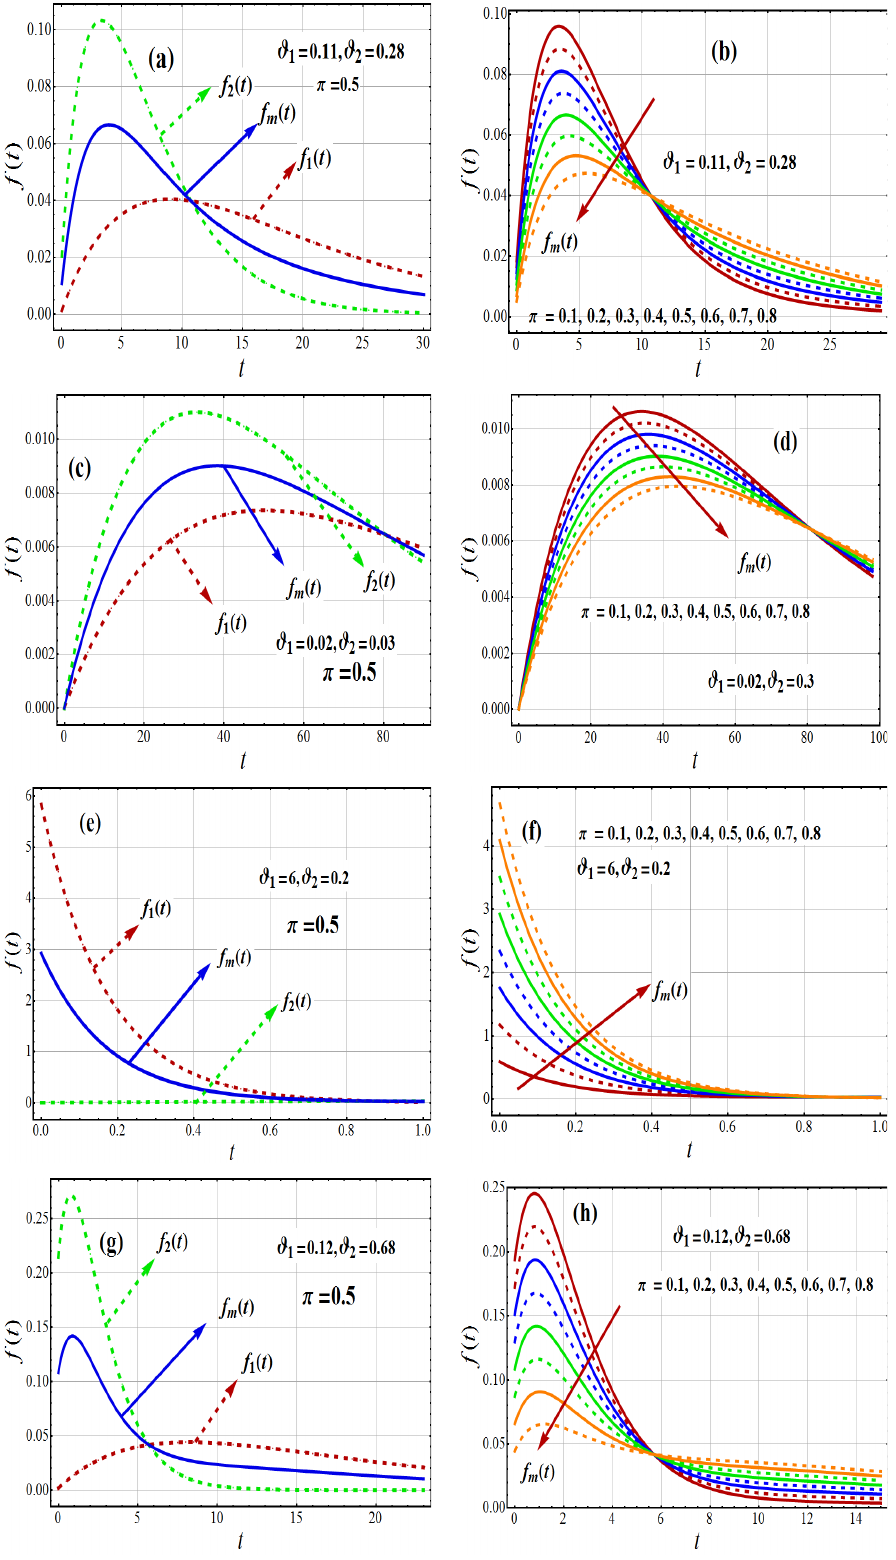
( t ) ; f ( t )) respectively, and density 1 2 ( t ) . of 2-CMSM f m